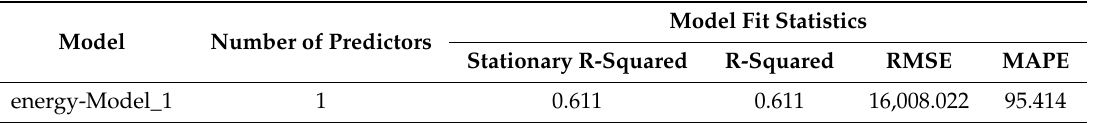
Table 4. The model statistics for NMGM-ARIMA.